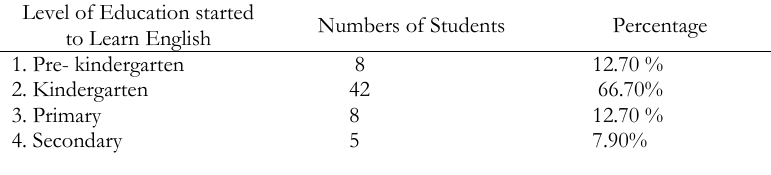
TABLE 1 . Level of Education started to Learn English